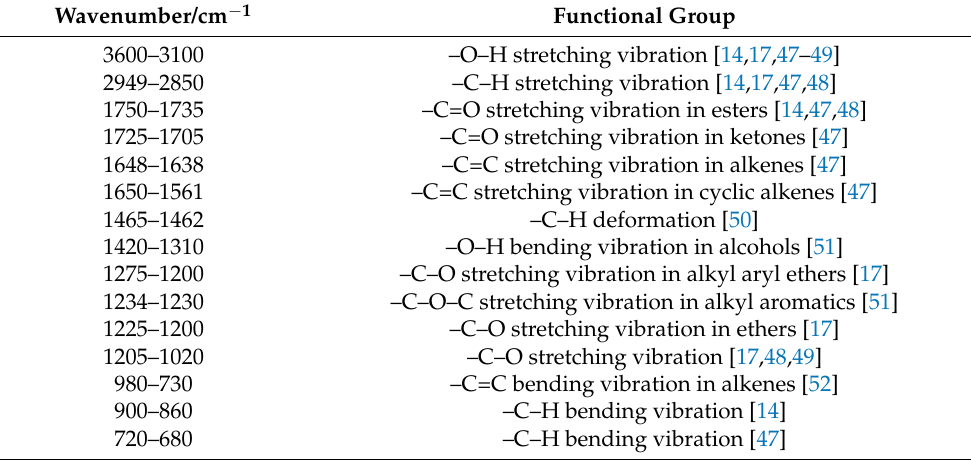
Table 6. ATR-FTIR wavenumber range for each assigned functional